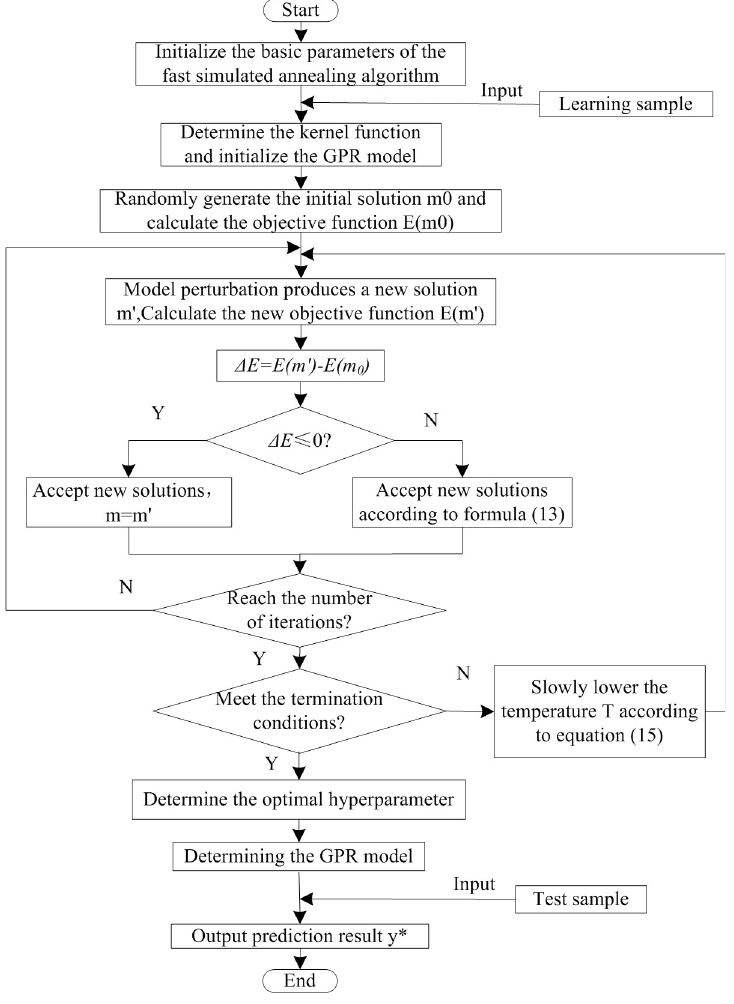
Fig 2. FSA optimized GPR prediction algorithm